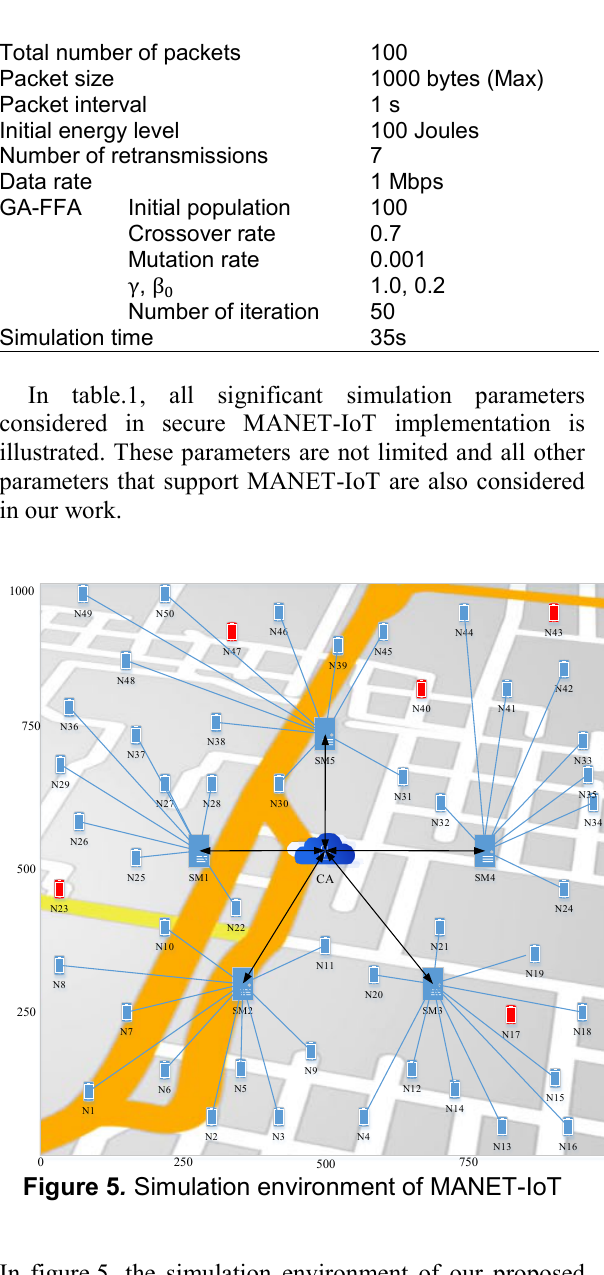
algorithm, RF-K means algorithm, GA-FFA algorithm and HMAC-AES algorithm are performed in